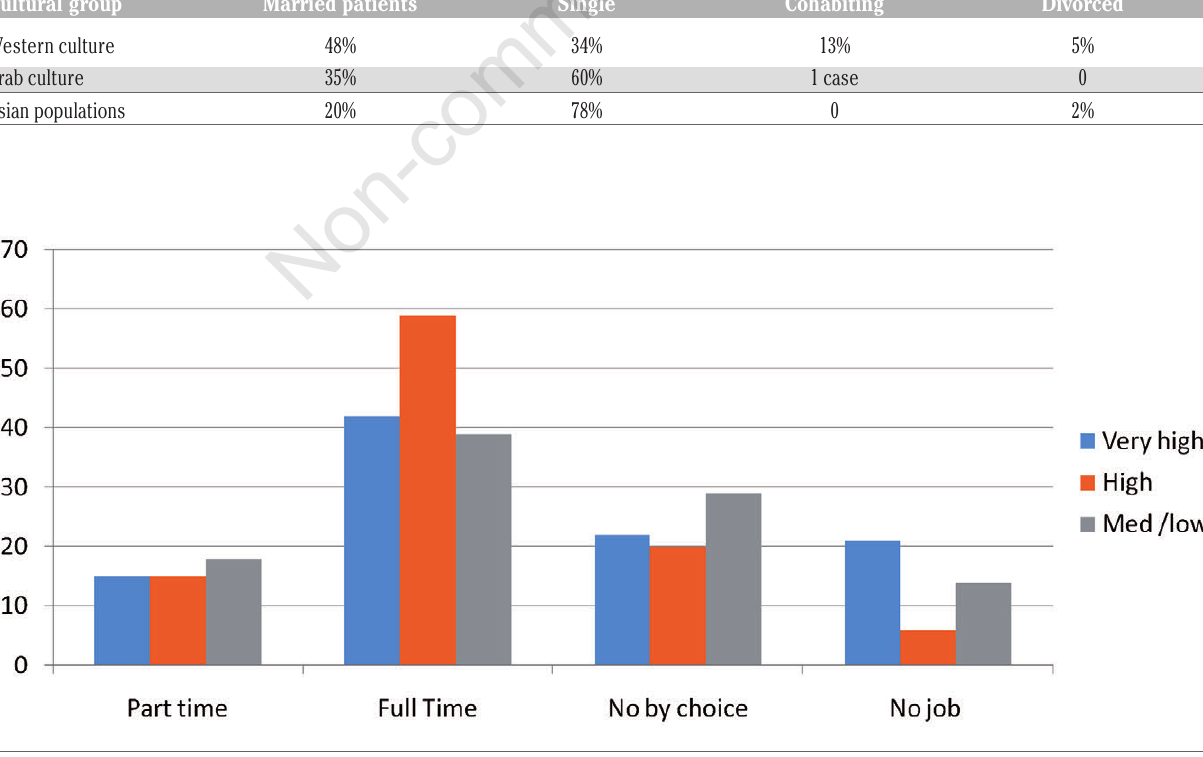
Figure 5. Employment status of thalassaemia patients according to country HDI